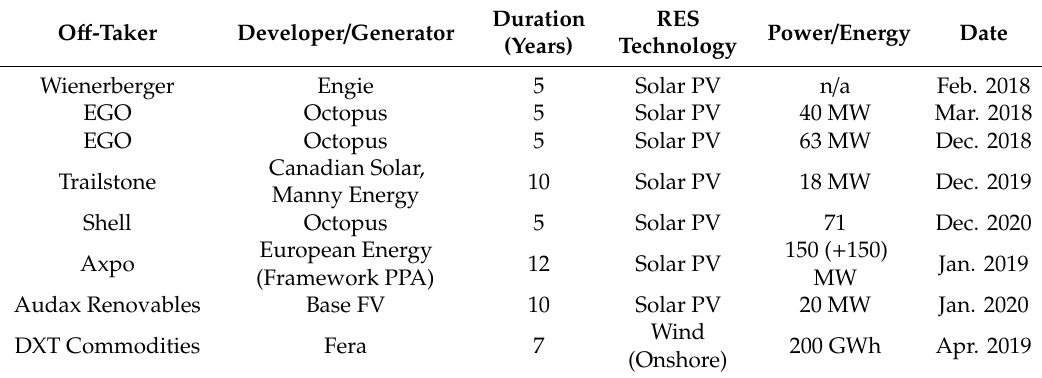
Table 8. RES PPAs’ negotiated contracts in the Italian market (2018–2020)